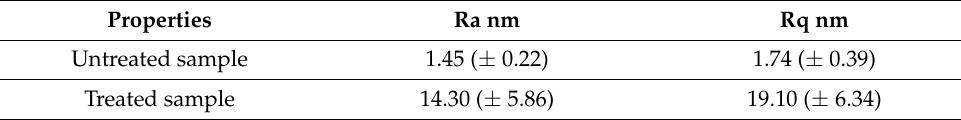
Figure 7. AFM results. ( a ) Untreated sample. The surface roughness of PET without plasma pre- treatment was low, and the height difference between the highest and lowest point is about 8.95 nm; ( b ) Treated sample. The surface roughness of PET with plasma pretreatment was high, and the height difference between the highest and lowest point is about 129.85 nm. Table 3. Surface roughness.